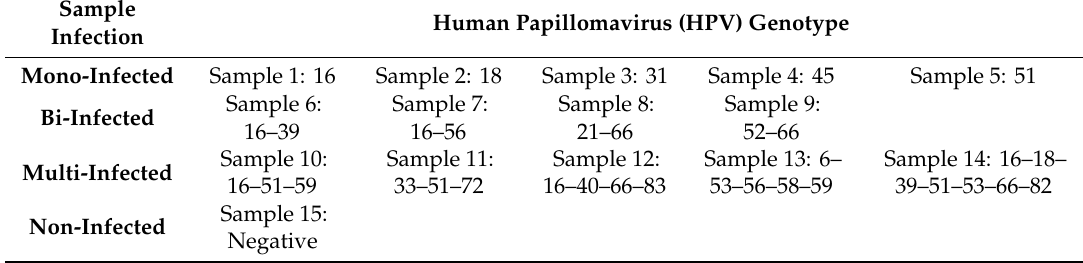
Table 1. Biological composition of samples used for artificial